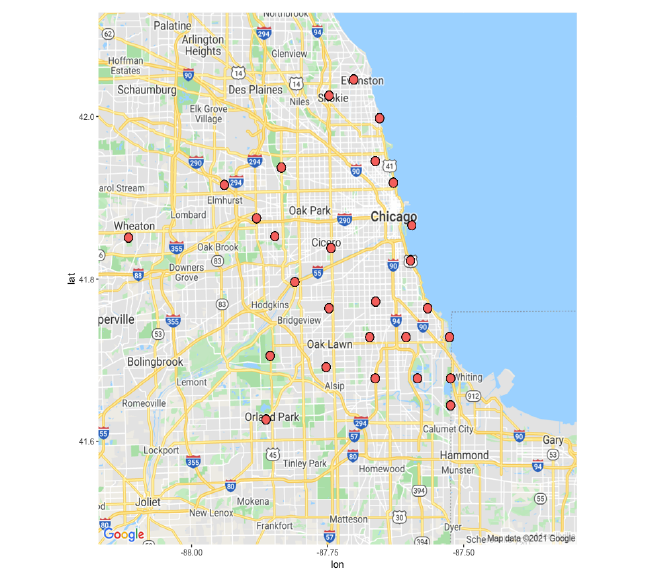
Figure 2. The sensor locations in the sparse